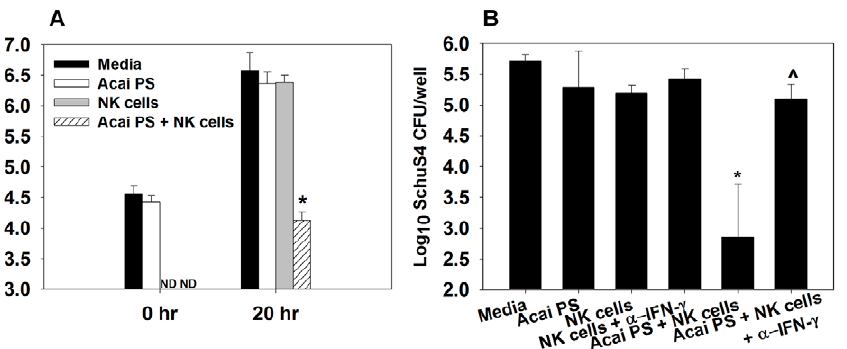
Figure 3. Acai PS reduces type A F.tularensis from primary human macrophages co-cultured with NK cells via IFN- c . A) and B) Primary human macrophages (10 5 /well, 3 wells/treatment) and NK cells were isolated and treated separately with 100 m g/ml Acai PS 16 h prior to infection with F. tularensis SchuS4 (MOI , 30). Neutralizing anti-IFN- c mAb, and/or autologous NK cells ( , 5 NK cells/macrophage) were also added to some wells. Either immediately after (0 hr) or twenty h after infection, NK cells (non-adherent) were removed and A) macrophages were lysed and intracellular bacteria enumerated. Error bars represent standard deviation. *P , 0.05 as compared to untreated macrophages. B) ‘ P , 0.05 as compared to Acai PS stimulated co-cultures neutralized of IFN- c . Results are representative of independent experiments from three different blood donors. Similar results were obtained in macrophages infected with LVS (data not shown). ND=not determined.